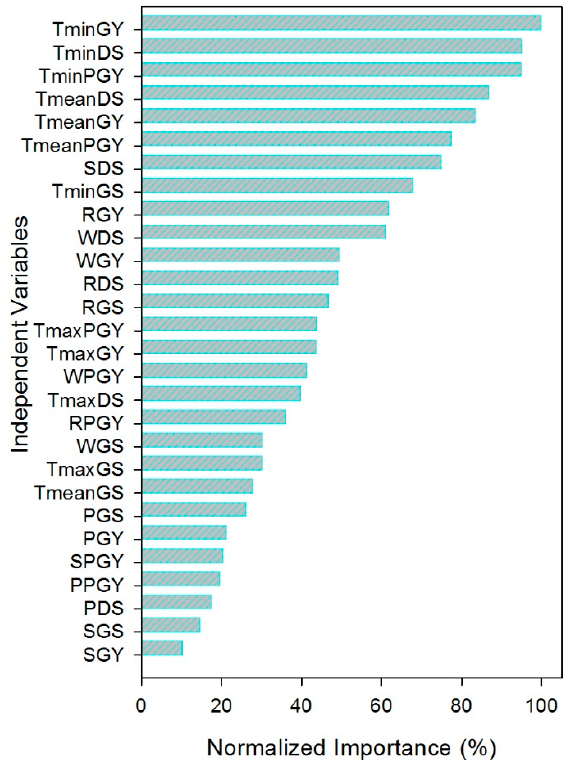
Figure 6. Normalized importance of climatic variables affecting carbon sequestration in ABM of P. schrenkiana in the Tianshan Mountains.